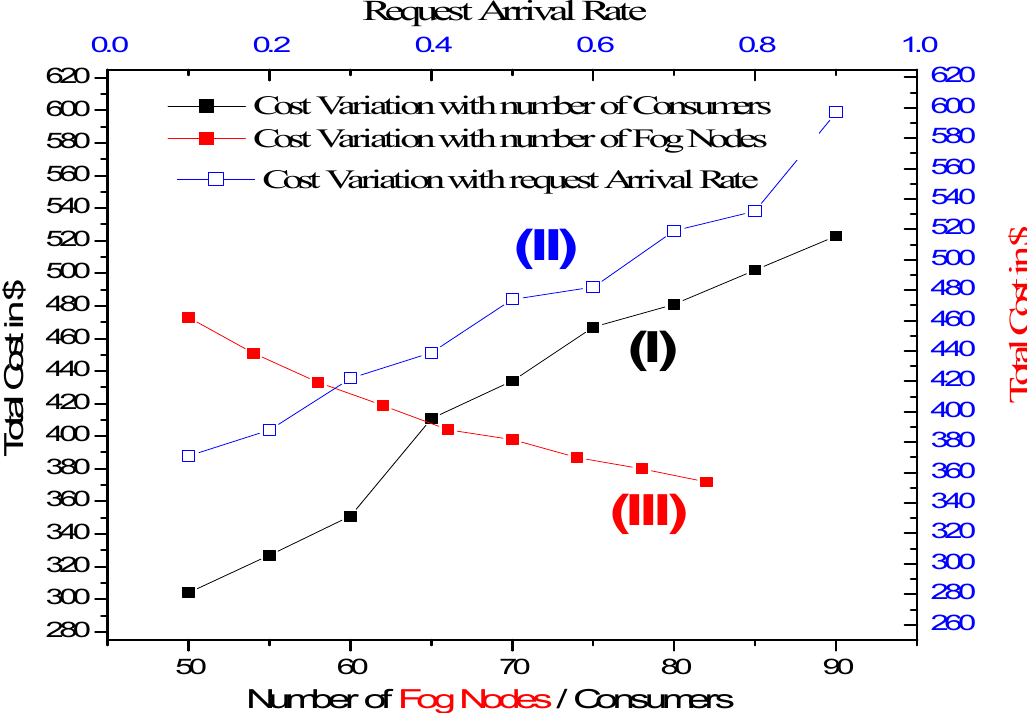
Figure 8. Cost variation with varying attributes.